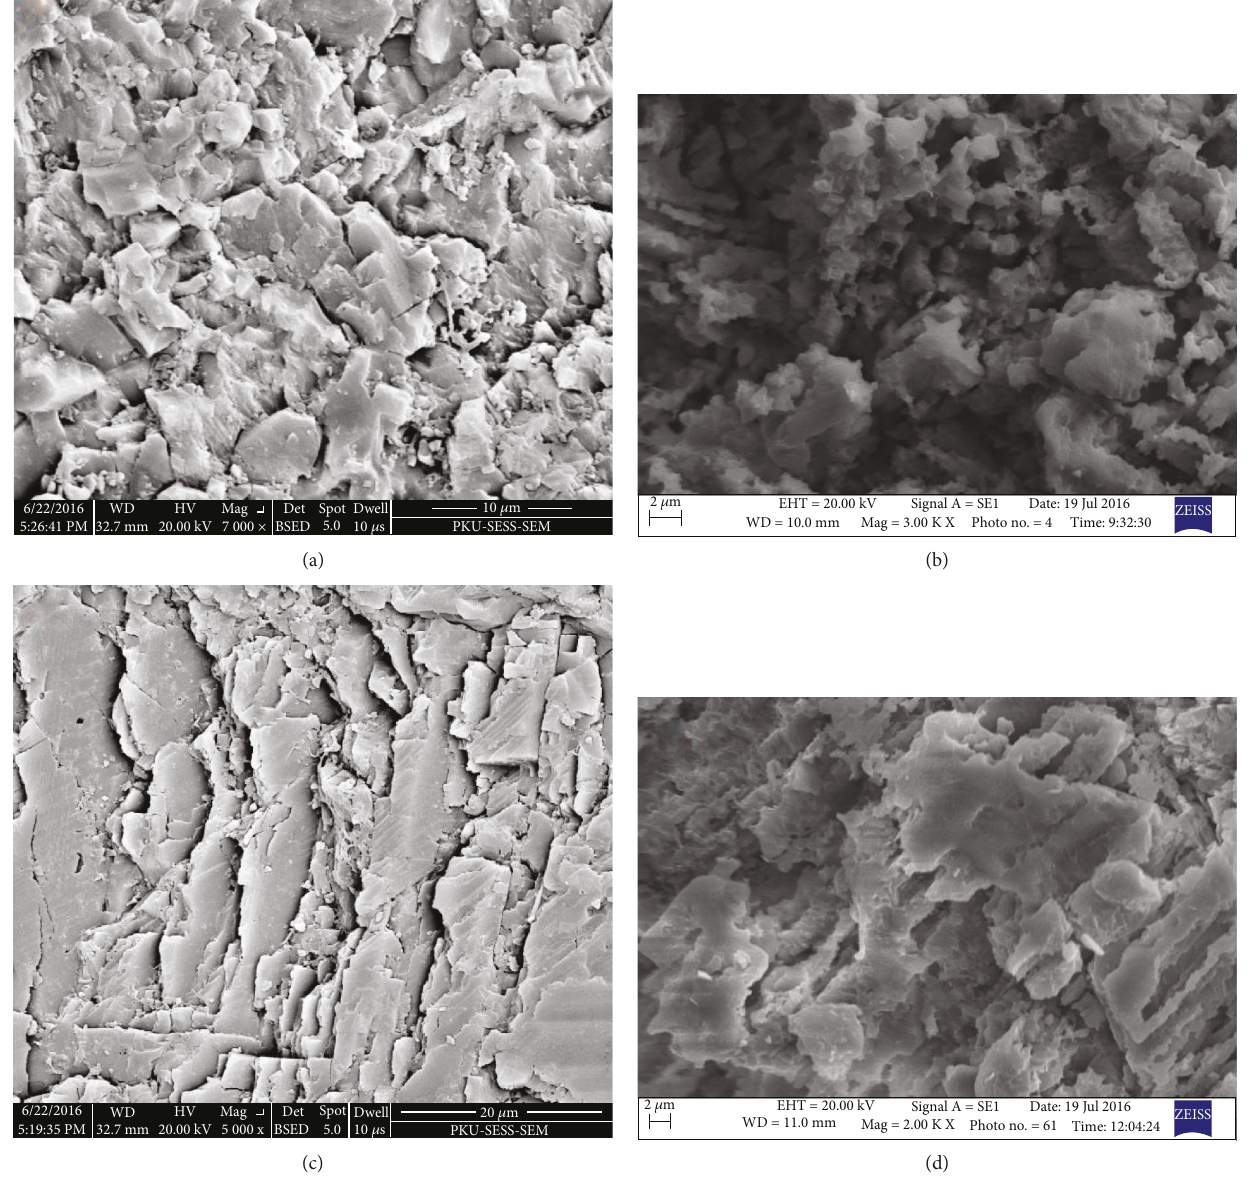
Figure 15: SEM photomicrographs of the calcite matrix and calcite vein of S (b) Postexperiment SEM photomicrographs of the calcite matrix. (c) Preexperiment SEM photomicrographs of the calcite vein. (d) Postexperiment SEM photomicrographs of the calcite